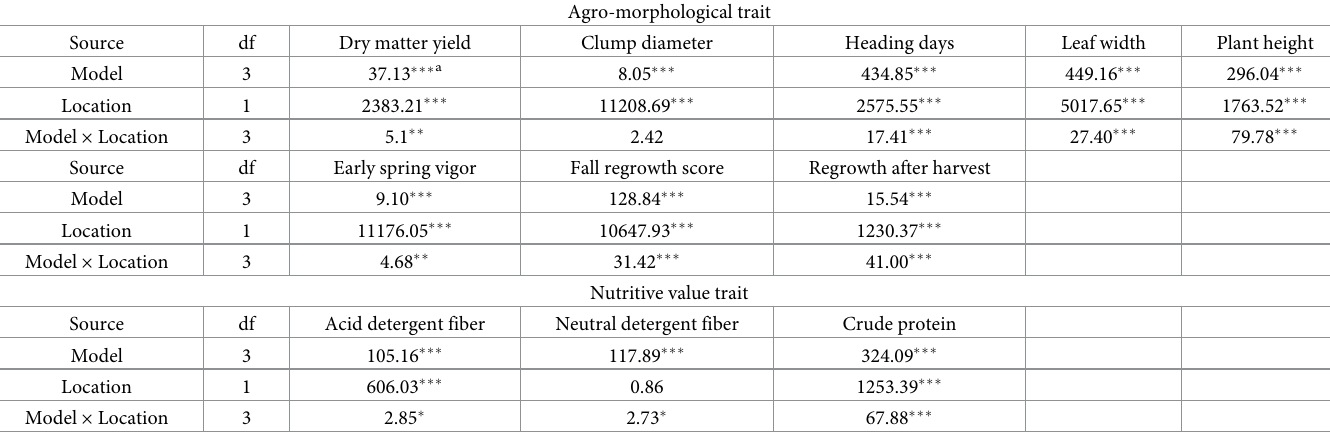
Table 7. Analysis of variance with genomic selection model and location as factors for 11 measured